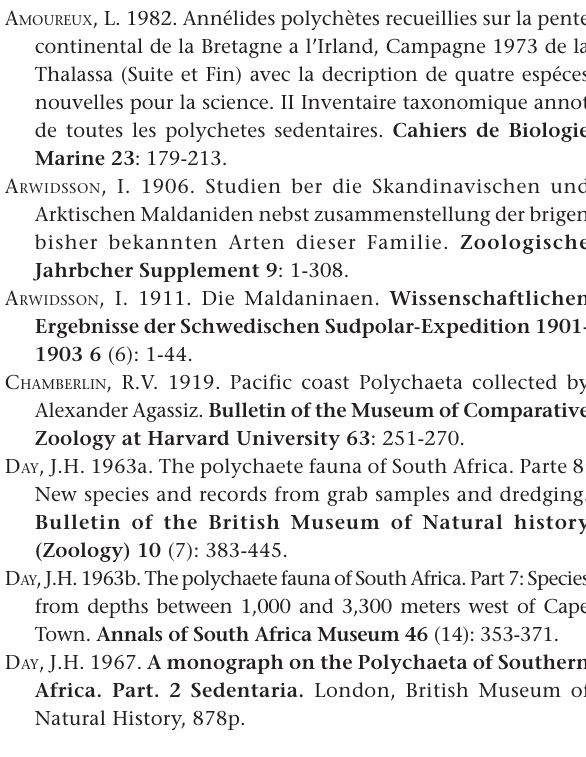
1011 Lumbriclymene interstricta comb. nov. with a taxonomic